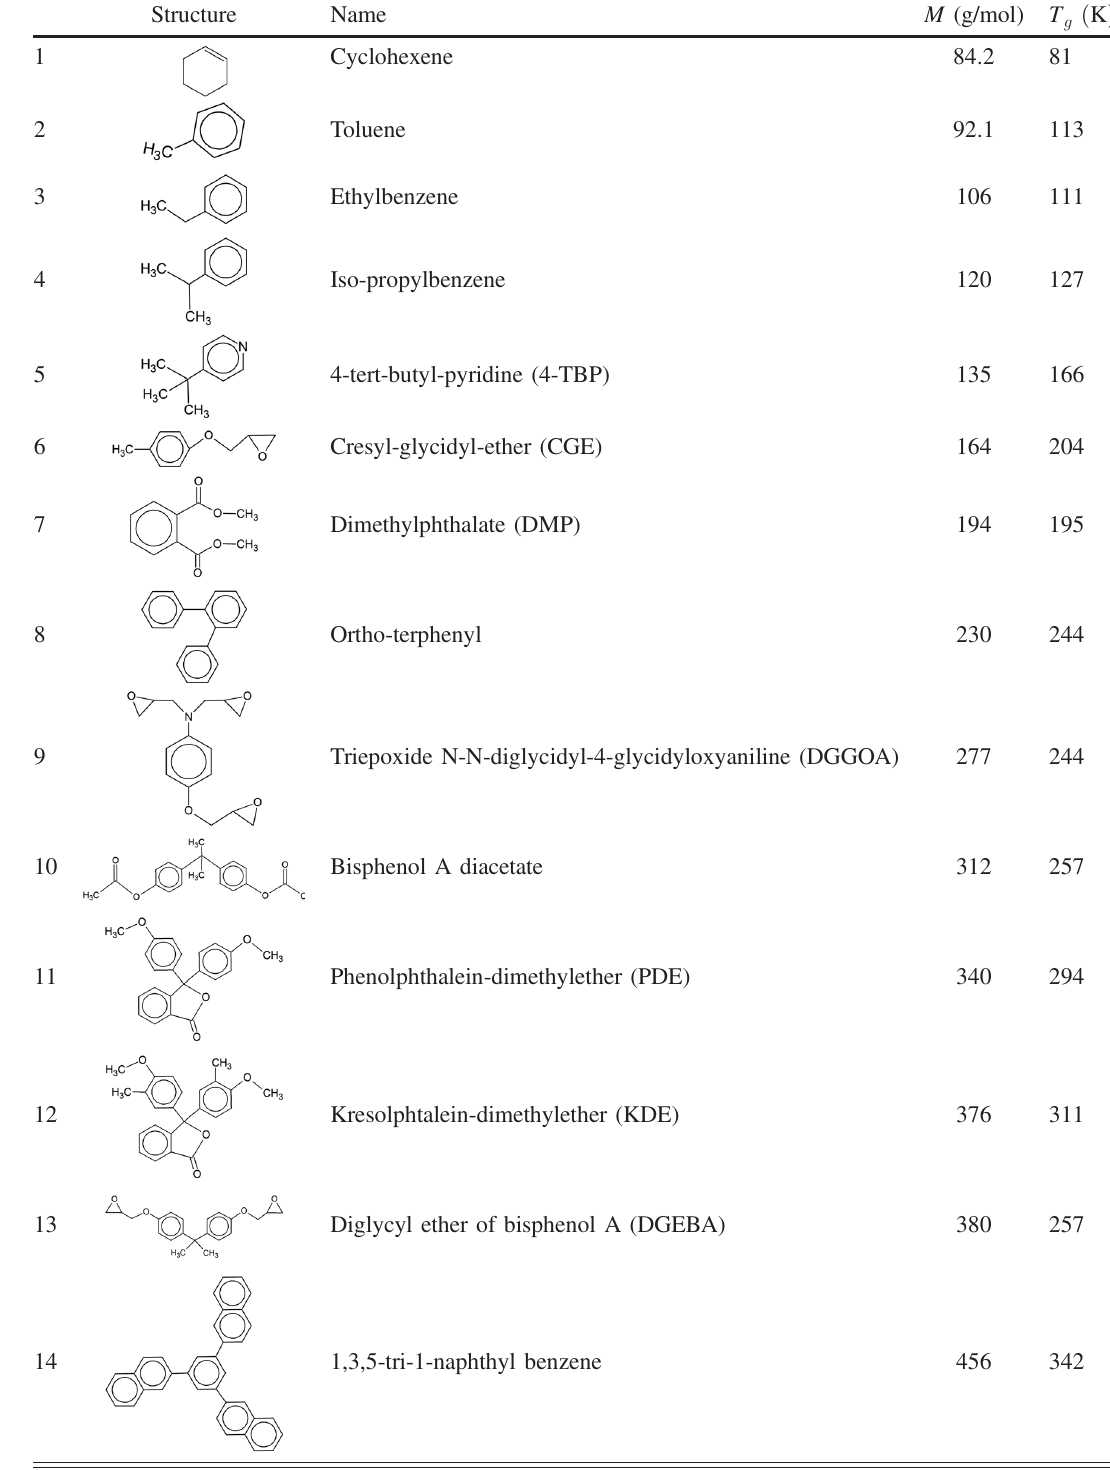
TABLE VI. Table of data compiled by Larsen and Zukowski [66], with the addition of molecule 10, for rigid, mainly aromatic, small molecular glass formers. These are ordered according to increasing molecular